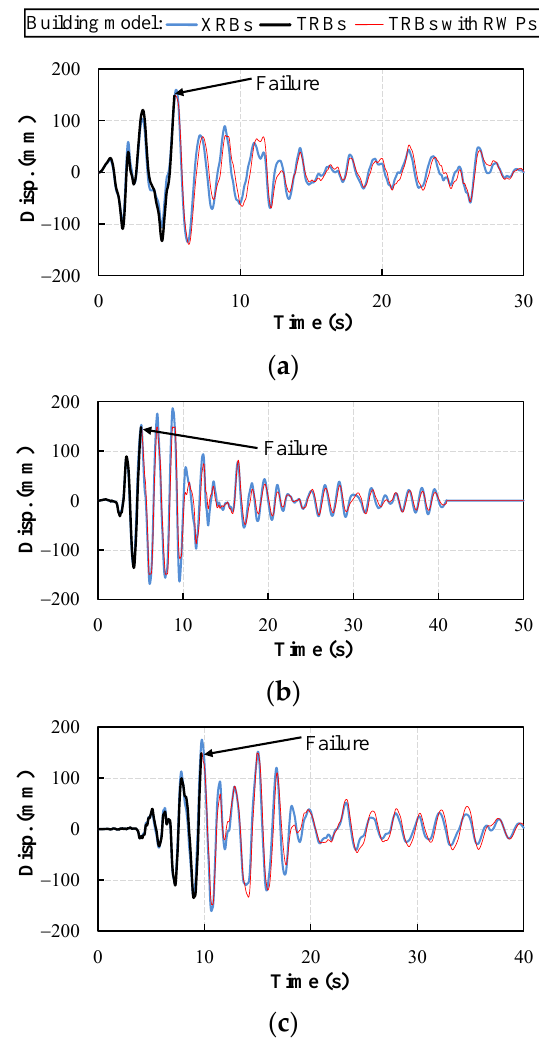
Figure 7. Displacements of the 1st floor under the ground motions at a 1 ‱ PE in one year: ( a ) El Centro; ( b ) Kobe; ( c ) Northridge.